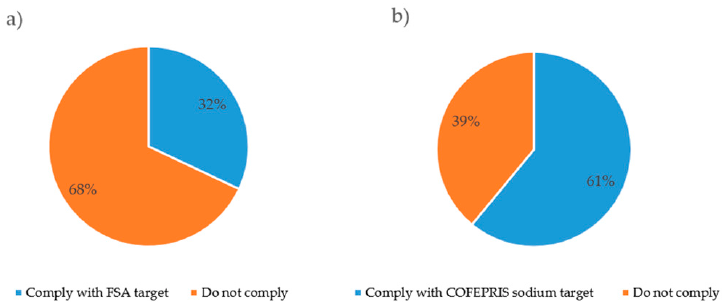
Figure 1. ( a ) Proportion of packaged foods meeting and exceeding the Food Standard Agency (FSA) sodium benchmark targets. ( b ) Proportion of packaged foods meeting and exceeding the Federal Commission for Protection against Health Risks (COFEPRIS by its acronym in Spanish) sodium targets ( n =